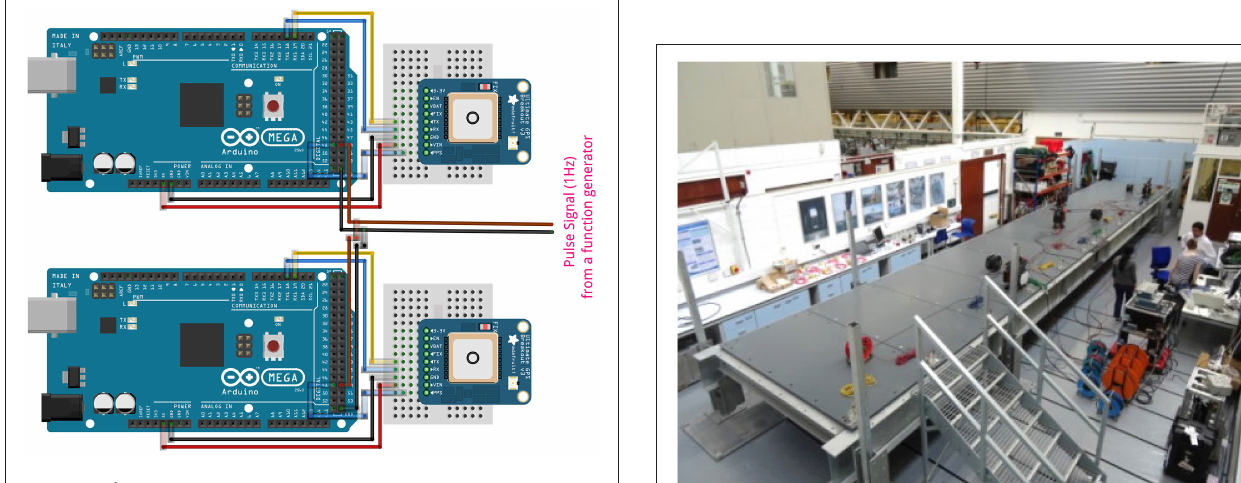
FIGURE 14 | Experimental setup for measuring time-stamping accuracy.